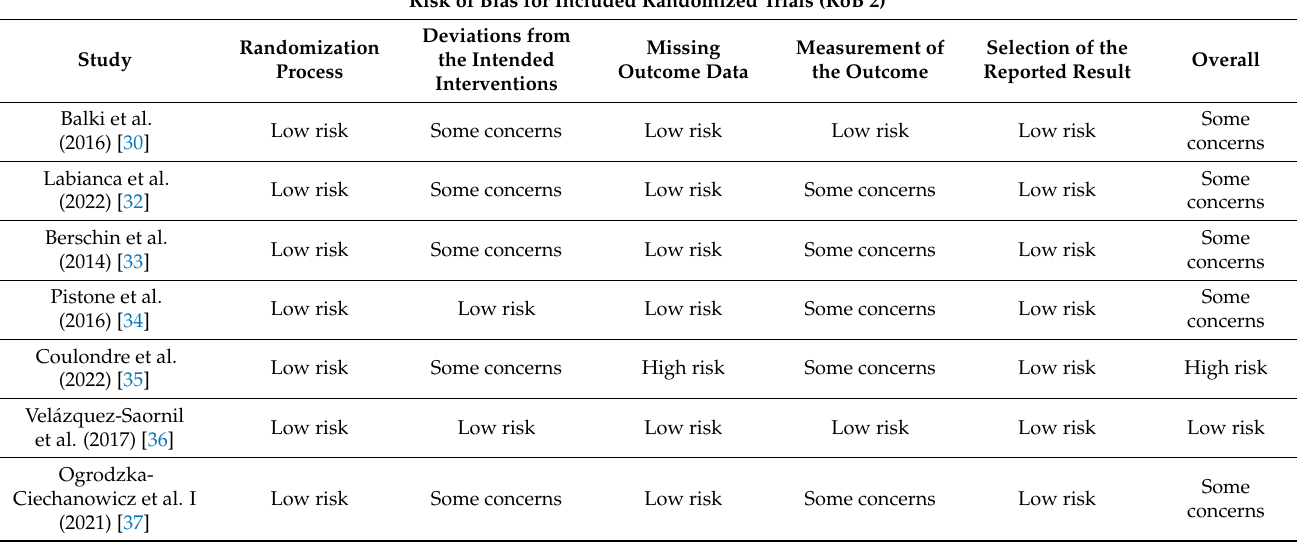
Table 5. Risk of Bias assessment of